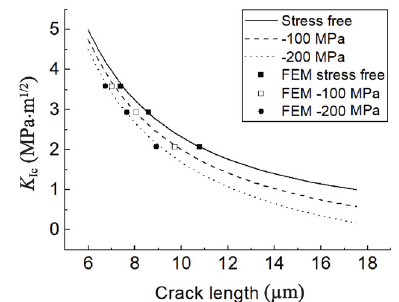
Fig. 16 FEM results of the crack shape with parametric critical strain energy release rate, where the light gray zones are still in contact, and the dark shaded gray represents debonded zones.